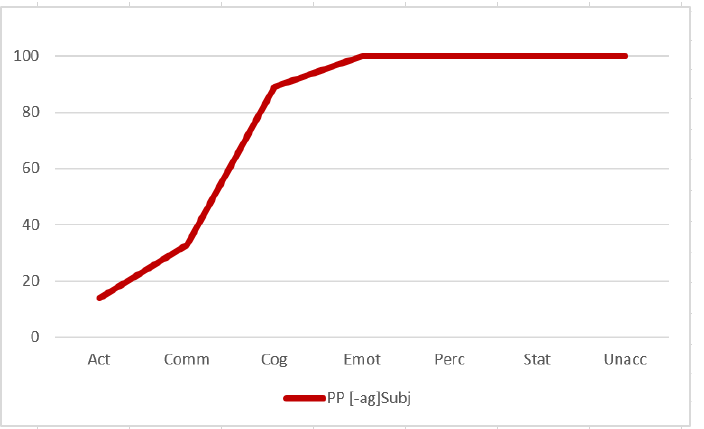
Figure 3. Percentage of Present Perfect with an affected subject within each type of verb